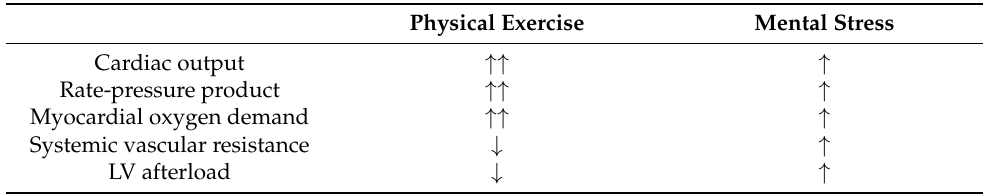
Table 1. Hemodynamic responses to physical exercise and mental